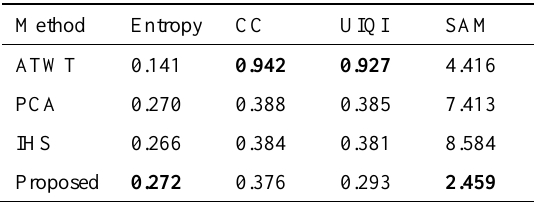
Table 3. Quality evaluation of fused images: water body and vegetation (corresponding to Figure 5). The best performance of each metric is in